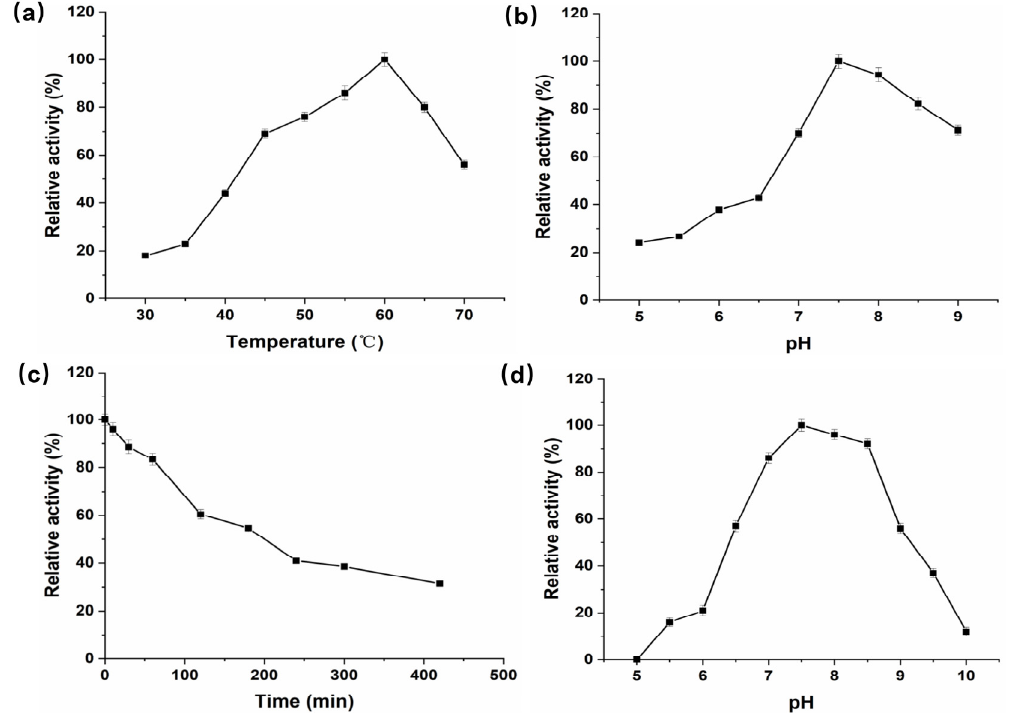
Figure 2. Enzymatic properties of recombinant P. geniculata AGEase. Optimal temperature for P. geniculata AGEase ( a ), the reactions were performed in 50 mM sodium phosphate buffer (pH 7.5) at 30–70 °C. Optimal pH for P. geniculata AGEase ( b ), the reactions were performed in 50 mM sodium phosphate buffer (pH 5.0–9.0) at 60 °C. Thermostability of P. geniculata AGEase at 50 °C ( c ), the reactions were performed in 50 mM sodium phosphate buffer (pH 7.5). The pH stability of P. geniculata AGEase at pH 5.0–10.0 ( d ), the reactions were performed in 50 mM sodium phosphate buffer (pH 5.0–10.0) at 60 °C.